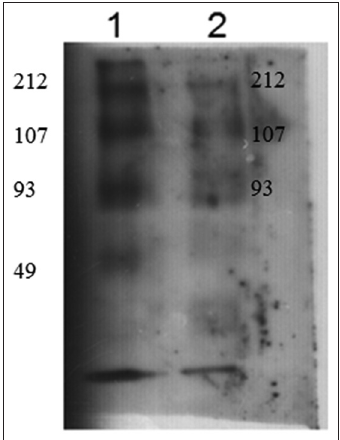
Figure-3: Western blotting showing immunoreactive bands of Toxocara vitulorum cuticle two isolated fractions.